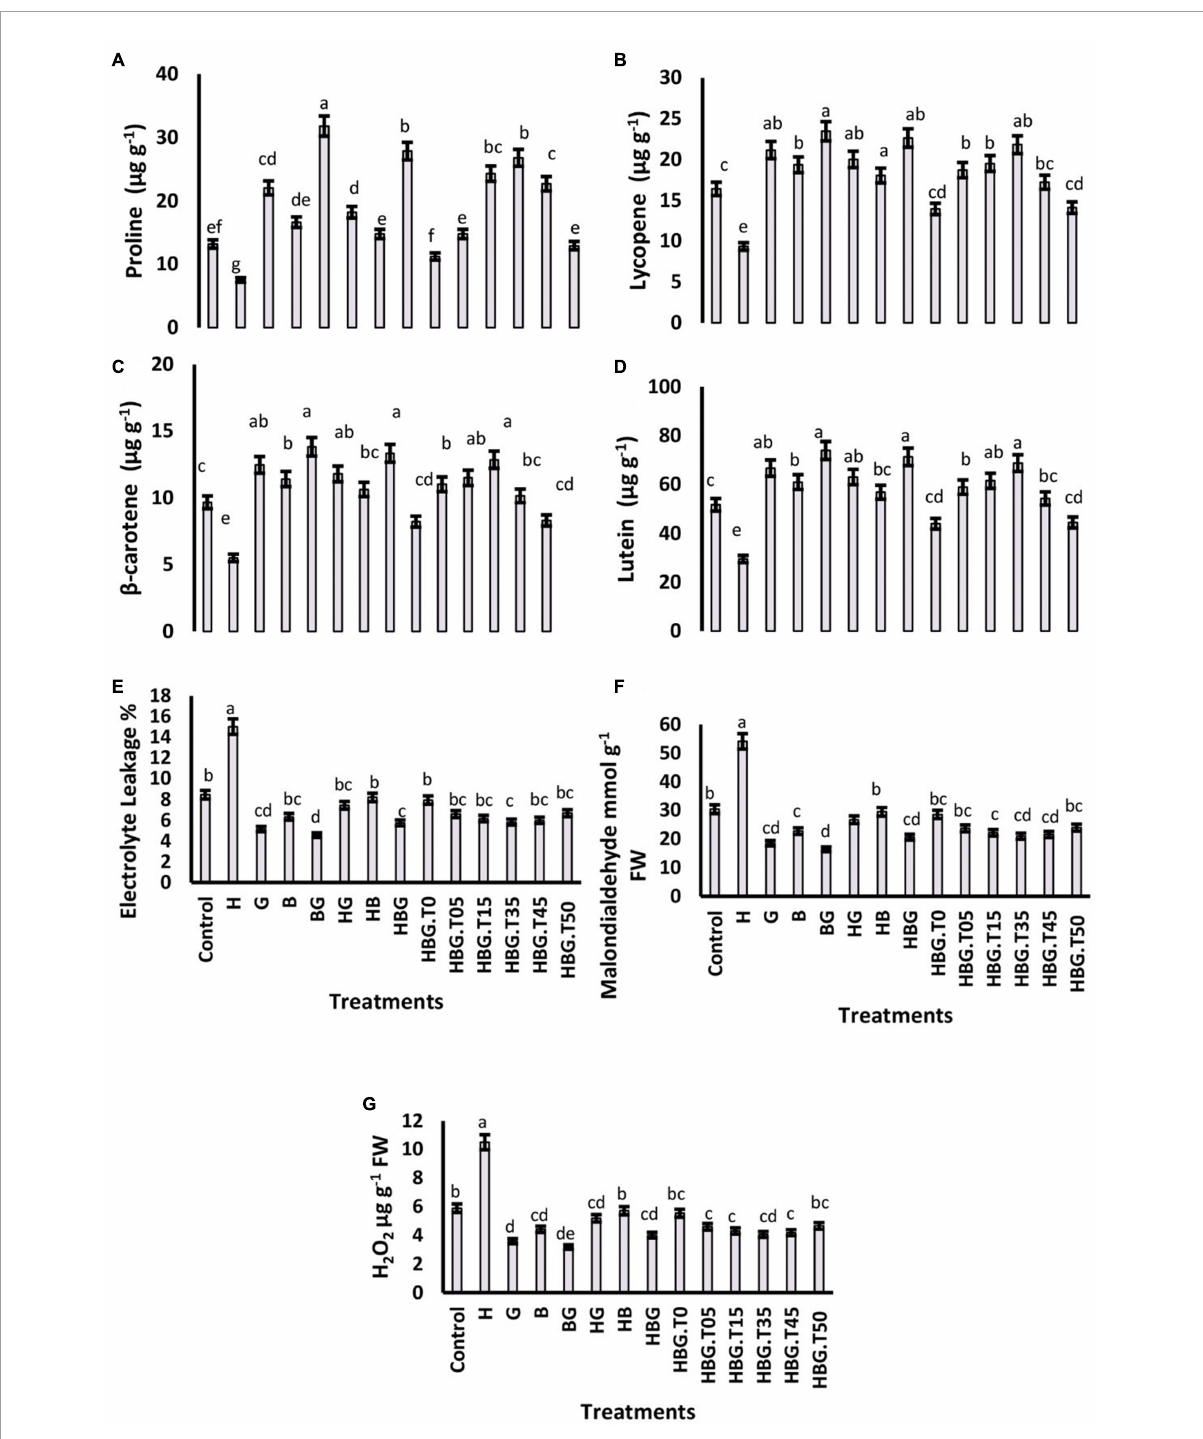
FIGURE3 Effect of GA 3 on physiological parameters of Brassica alboglabra under HCB toxicity, and temperature stress. Proline content (A) , Lycopene content (B) , β -carotene content (C) , and Lutein content (D) , Electrolyte leakage (E) , Malondialdehyde content (F) , and H 2 O 2 content (G) . Values demonstrate means ± SD ( n = 5). Different letters indicate a significant difference among the treatments ( P ≤ 0.05). H = HCB; G = GA 3 , B = Bioclay, T0 = 0 ◦ C, T05 = 05 ◦ C, T15 = 15 ◦ C, T35 = 35 ◦ C, T45 = 45 ◦ C, T50 = 50 ◦ C. All treatments without temperature tags got a continuous incubation temperature of 25 ◦